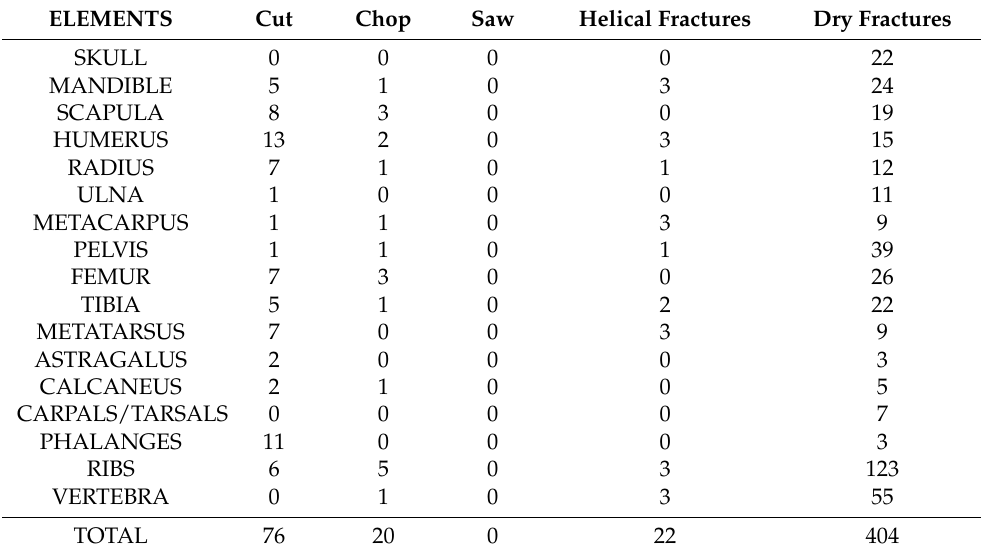
Table 3. Number of cattle remains with different recorded butchery marks, helical fractures, and dry fractures documented in the Vilauba